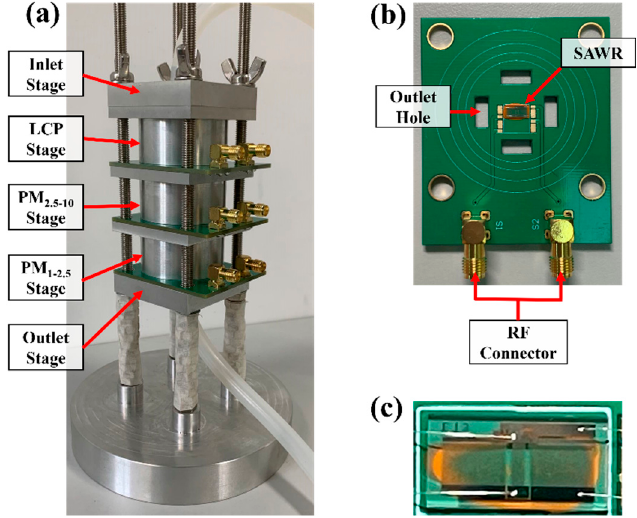
Figure 12. The photograph of the cascade impactor assembled with the surface acoustic wave resonator: ( a ) sensor; ( b ) SAWR placed on the impaction circuit board; ( c ) 311 MHz SAWR.